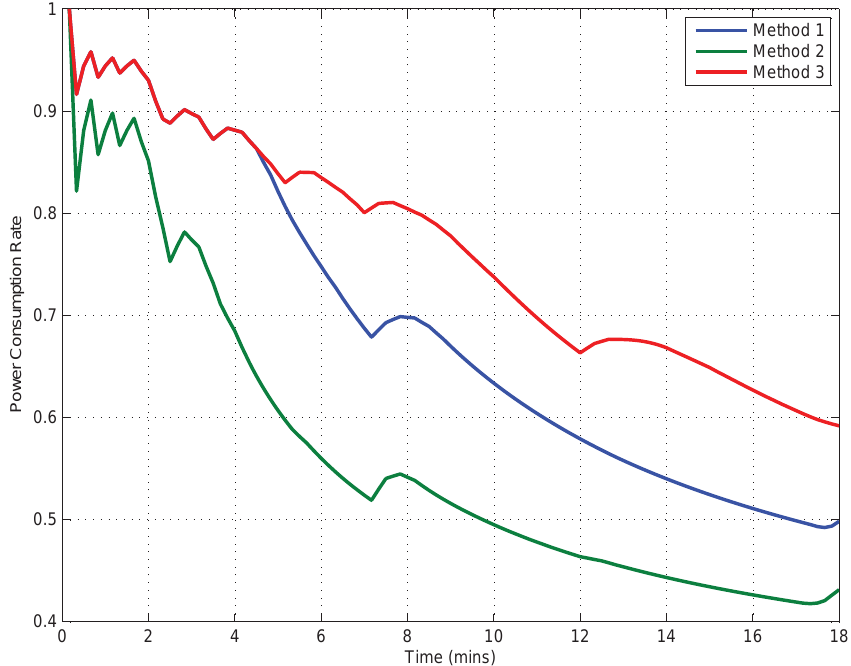
Figure 5. Power consumption ratio analysis in comparison to the aggressive sampling (DC = 100%, f = 100 Hz) (results are averaged with respect to the s